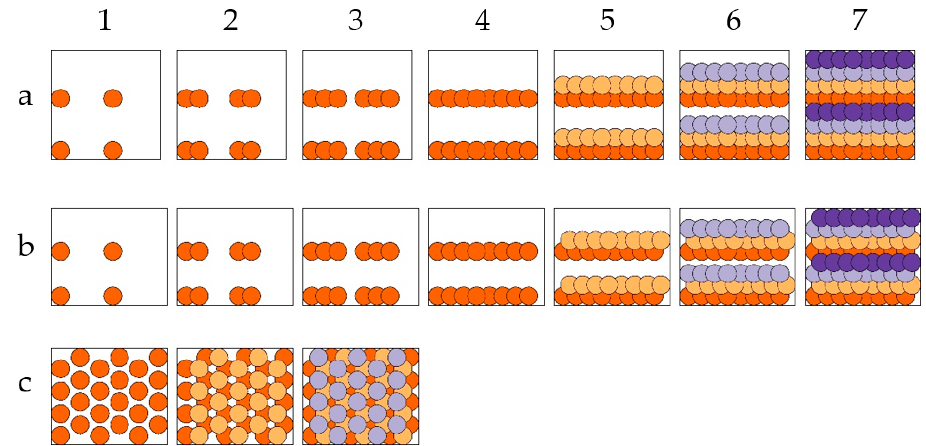
Figure 3. Illustration of three different printing strategies. Circular areas represent the voxels with the respective x/y-positions on the receiver substrate. Steps 1 to 7 illustrate the sequence in which overlapping voxels were printed, leading to three different arrangements of unit cells: ( a ) with four layers of two-row prints, each consisting of 16 voxels; ( b ) with four staggered layers of two-row prints, each consisting of 16 voxels; ( c ) with three staggered layers of hexagonally ordered prints consisting of 20 or 24 voxels. Voxels of the same layer are shown in an identical